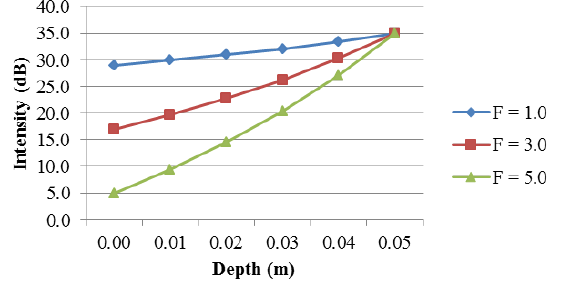
Figure 4: Intensity depth plot where the intensity of the audio ob- ject is tied to the depth between scans and the attenuation depends on factor F .